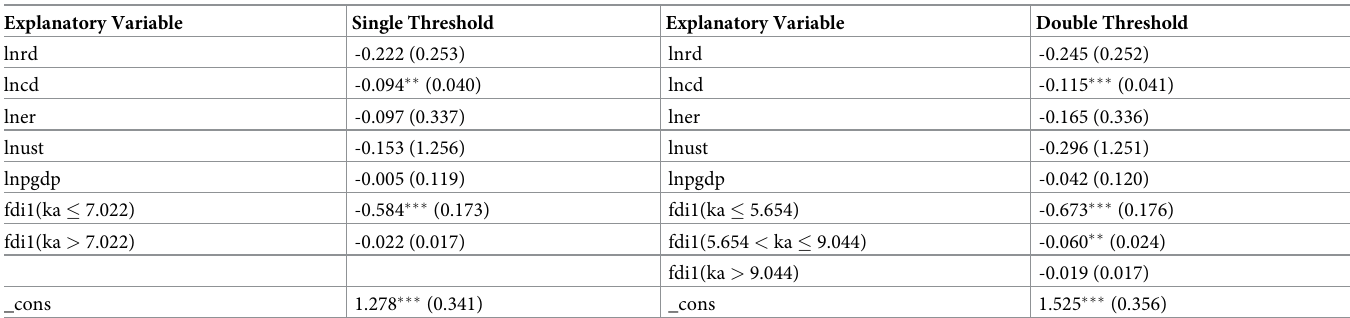
Table 5. FDI quantity threshold model estimation results.